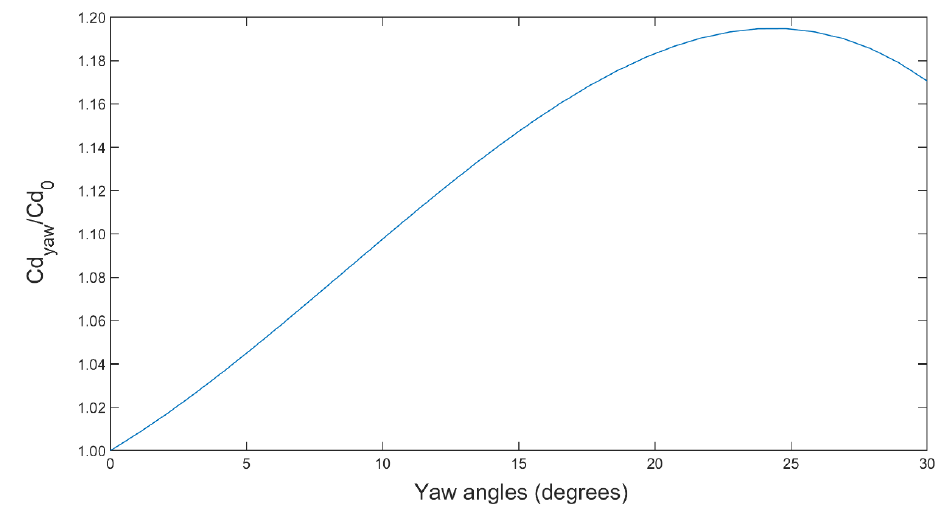
Figure 2. Increase in the drag coefficient with respect to the yaw angle.